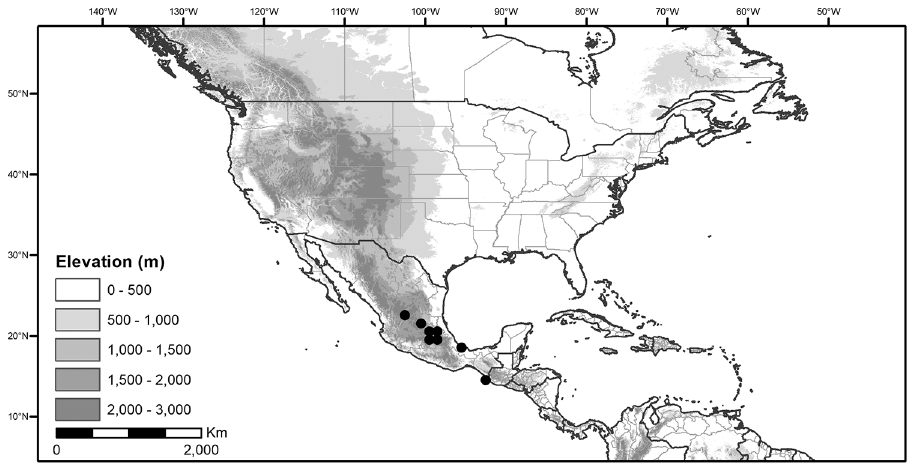
Figure 11. Distribution of Solanum corymbosum